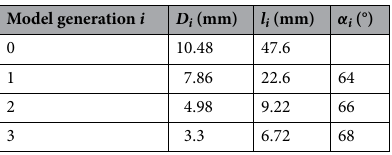
Table 1. Geometrical characteristics of the simplified lung model.